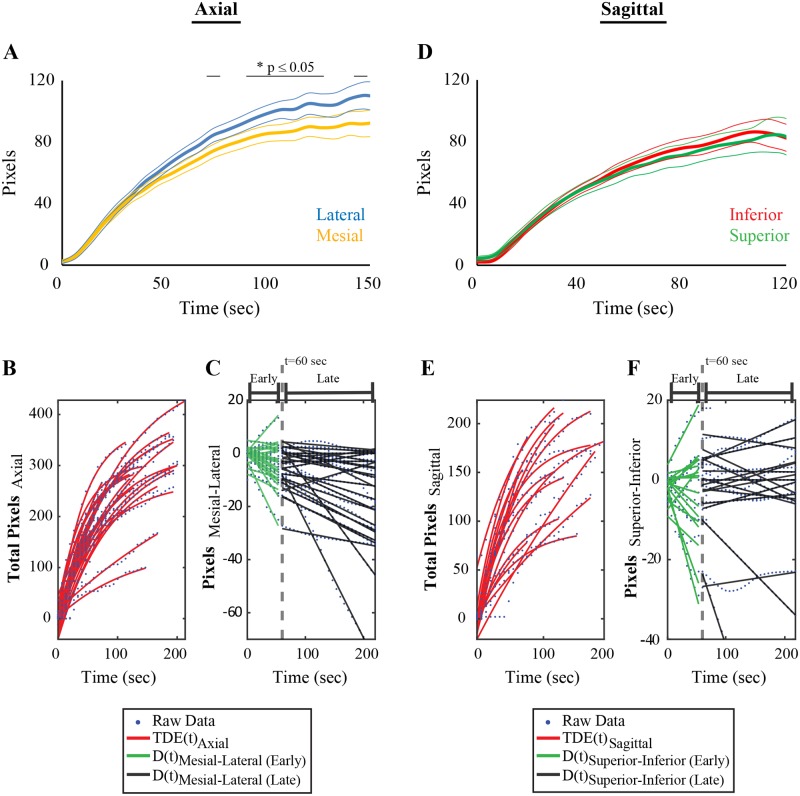
Mesiotemporal LITT ablation asymmetry.(A) Time course of pixel counts lateral (blue) and mesial (yellow) to the laser averaged from all axial TDE maps (N = 29). Pixel counts were greater lateral vs. mesial to the laser past 60 seconds, with statistically significant differences between the curves shown with a horizontal line above the graph. At each time point, significance was evaluated with bootstrap analysis using p ≤ 0.05 as the criterion. (B) Pixel counts measured from the axial TDE videos fit with exponential curves for each patient (N = 28). (C) Difference in mesial and lateral pixel counts modeled with best-fit lines for each patient, done separately for early and late differences, distinguished by the 60 second time point (dotted grey line). (D-F) Same conventions as A—C but calculated from sagittal TDE maps (N = 16). Unlike for the axial maps, no differences were found for pixel counts measured superior (green) vs. inferior (red) to the laser.